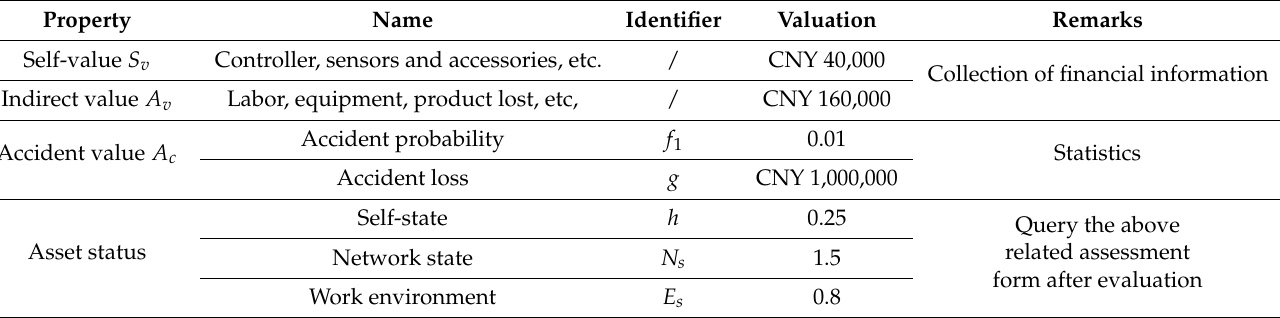
Table 8. Basic value datasheet of the robot unit.